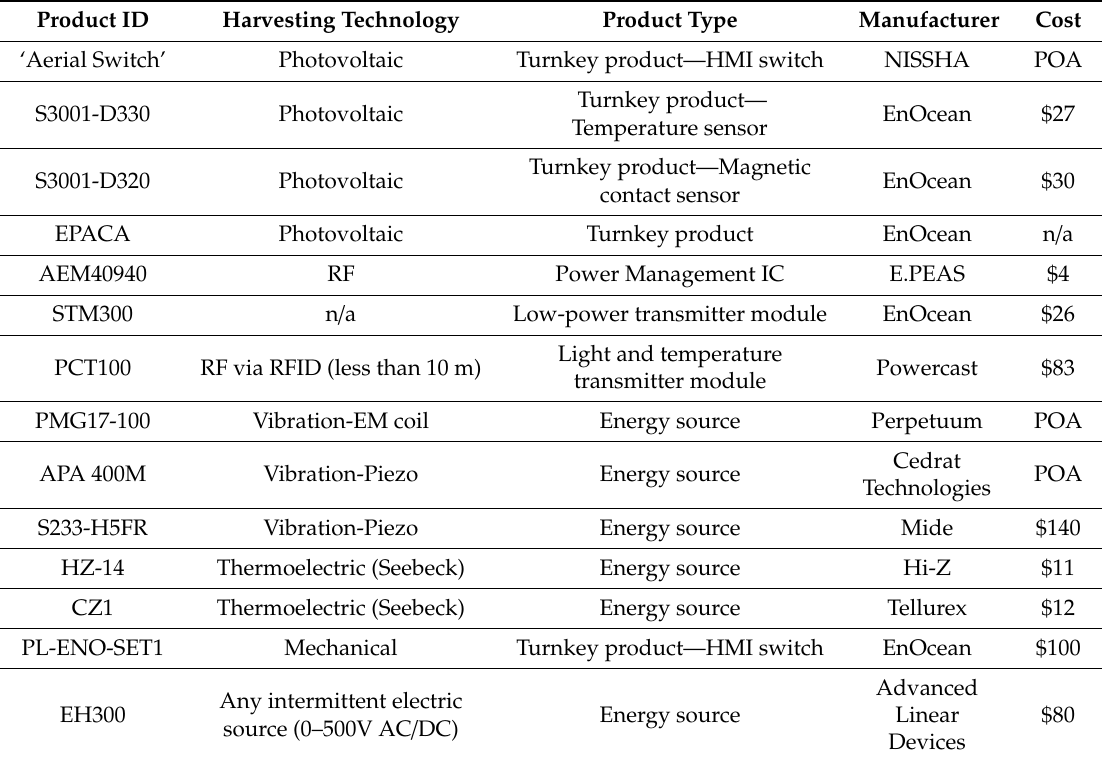
Table 6. Comparison of various commercial energy harvesting solutions available for potential use in